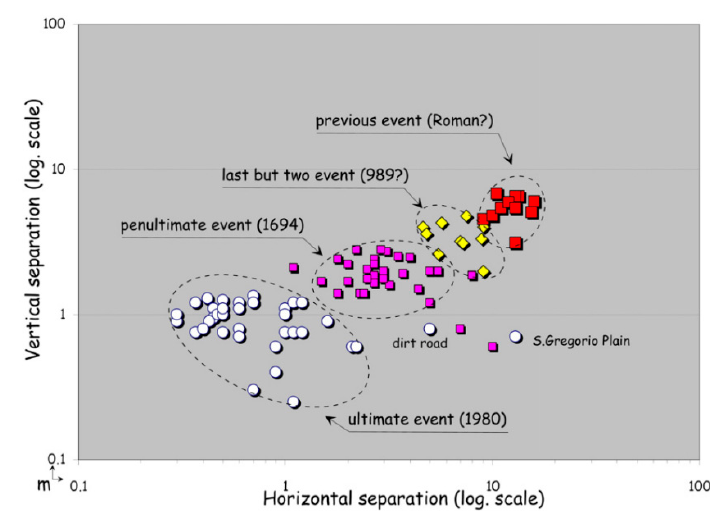
Figure 5. Horizontal versus vertical separation values measured through high-precision topographic profiles across the compound fault scarp of Monte Marzano faults (vertical values are cumulated). The different clusters provide evidence for at least four major surface-faulting events. The older the rupture, the higher the vertical and horizontal separation (mod. from [6]).